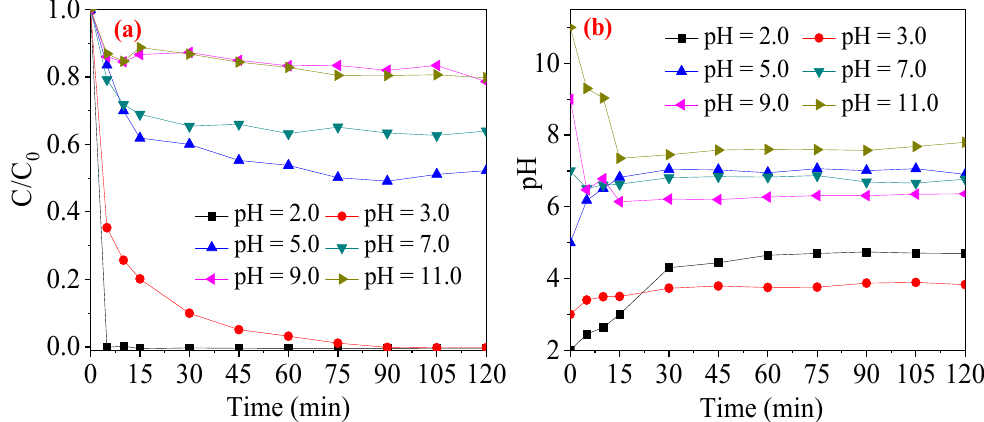
Figure 3. ( a ) Removal of Cr(VI) by nZVI as a function of time at different initial pH. ( b ) The change of solution pH with reaction time. ([Cr(VI)] = 25 mg/L, [nZVI] = 0.5 g/L, T = 293 K).